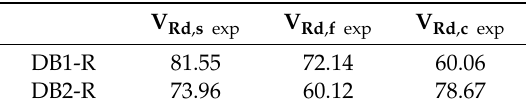
Table 4. Experimental contribution to the shear resistance of the transverse steel reinforcement (V Rd,s exp ), the CFRP reinforcement (V Rd,f exp ) and the concrete (V Rd,c exp )